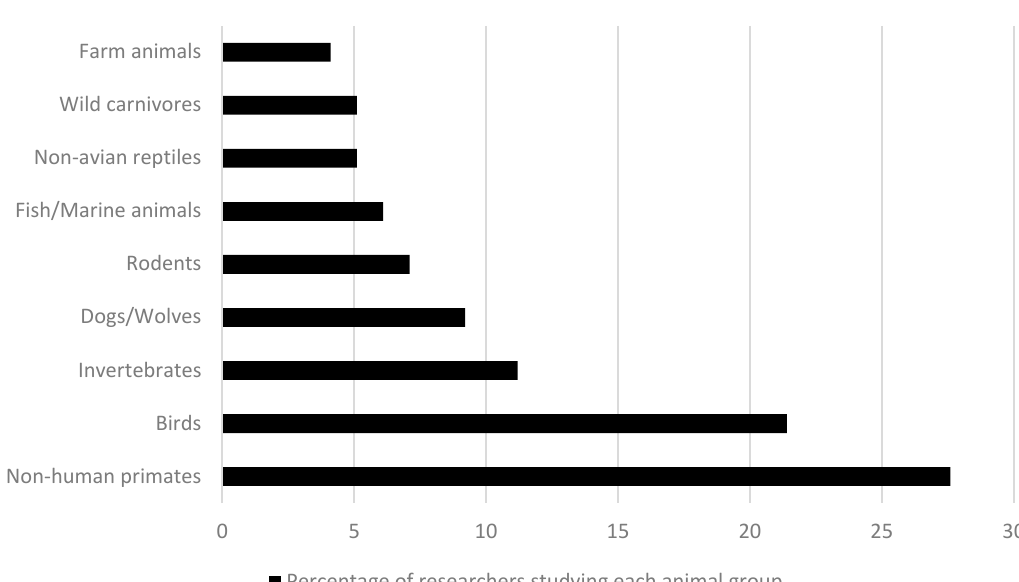
Figure 1. Distribution of the groups of animals studied in a sample of N = 98 Ethology researchers.